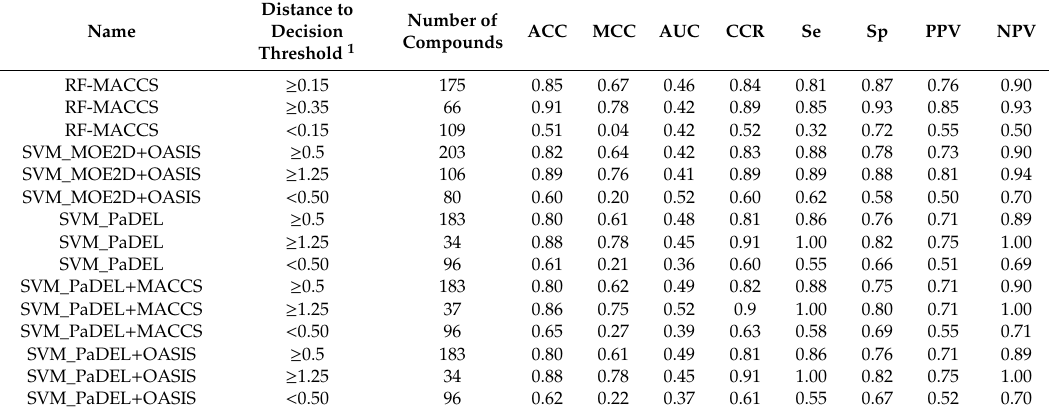
Table 7. Test set performance as a function of the distance of predicted class probabilities from the decision